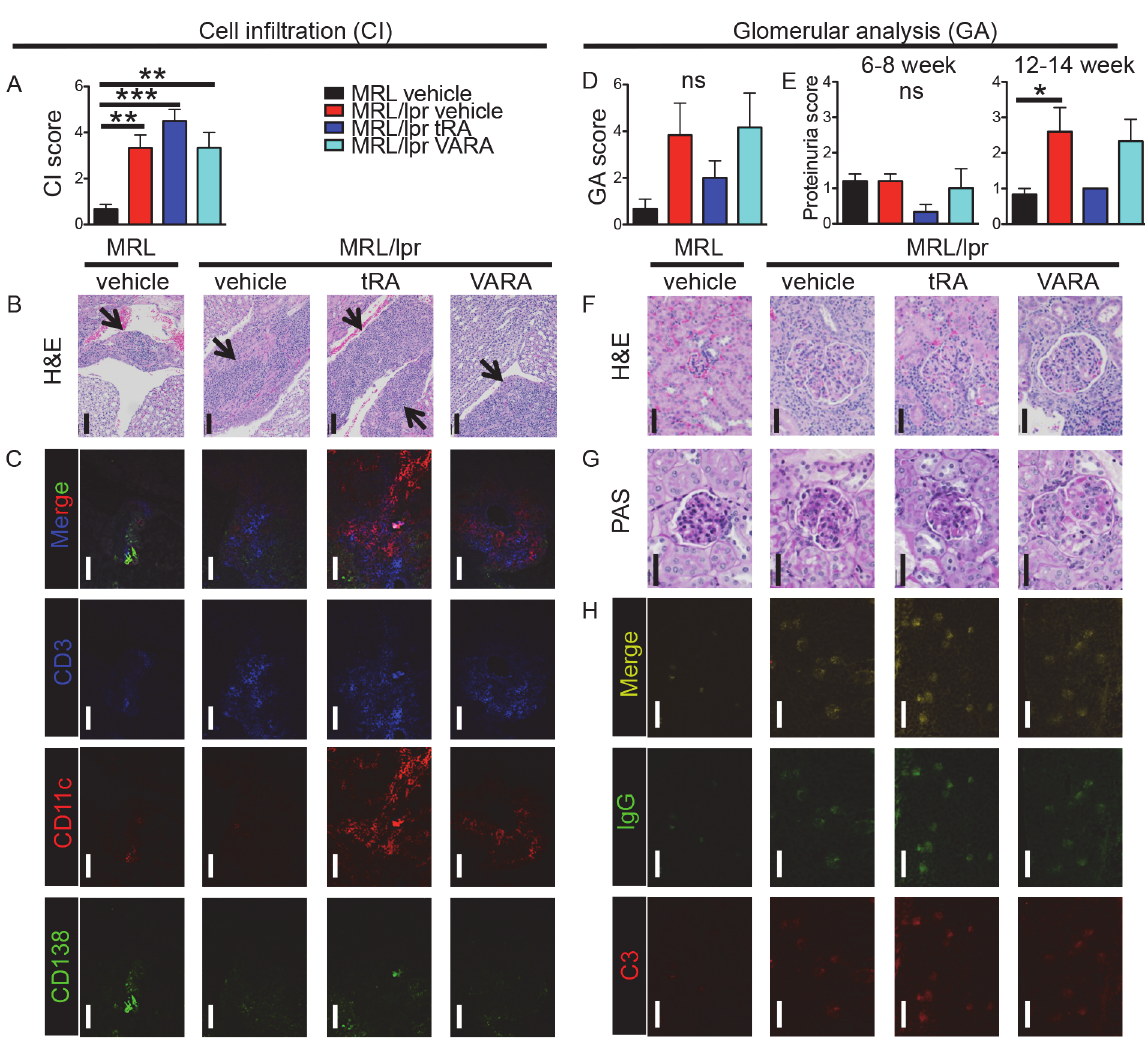
Fig 3. tRA-mediated modulation of kidney pathology. (A-C) Leukocyte infiltration of the tubulointerstitial region. (A) Cell infiltration (CI) scores according to H&E stains. (B) Representative micrographs of H&E stains of the tubulointerstitial region. Bar equals 100 μ m. Areas of infiltration are indicated by arrows. (C) Immunohistochemical stains of T cells (CD3-blue), dendritic cells (CD11c-red), and plasma cells (CD138-green). Representative images are shown. Bar equals 100 μ m. (D-H) Glomerular analysis (GA). (D) Average GA scores of hypercellularity, mesangial matrix expansion, necrosis, percentage of sclerotic glomeruli, and glomerular crescents. (E) Analysis of proteinuria. The level of total protein in the urine was measured weekly with Chemstrip 2GP. The data of 6- to 8-week-old time points were combined as the early stage, and those of 12- to 14-week-old time points were combined as the late stage. (F) Representative H&E stains showing kidney glomeruli. Bar equals 60 μ m. (G) PAS stains showing kidney glomeruli. Bar equals 40 μ m. (H) Immunohistochemical stains of IgG (green) and complement C3 (red) deposition in the kidney cortex. Bar equals 200 μ m. ns: not significant, * P < 0.05, ** P < 0.01, *** P < 0.001, one-way ANOVA. Data are shown as mean + SEM (n = 6 mice in each